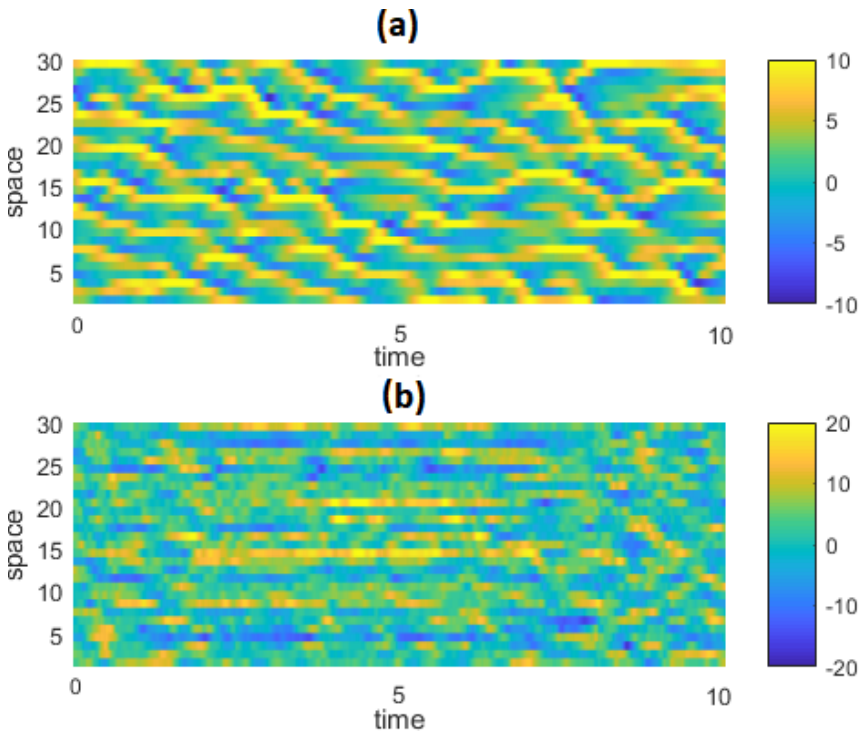
Figure 8. Example of (a) target Lorenz 1996 spatio-temporal evolution of large-scale variables X for c = 1 ,h = 1 and (b) ESN prediction realized with N = 800 neurons. Note that the colours are not on the same scale for the two